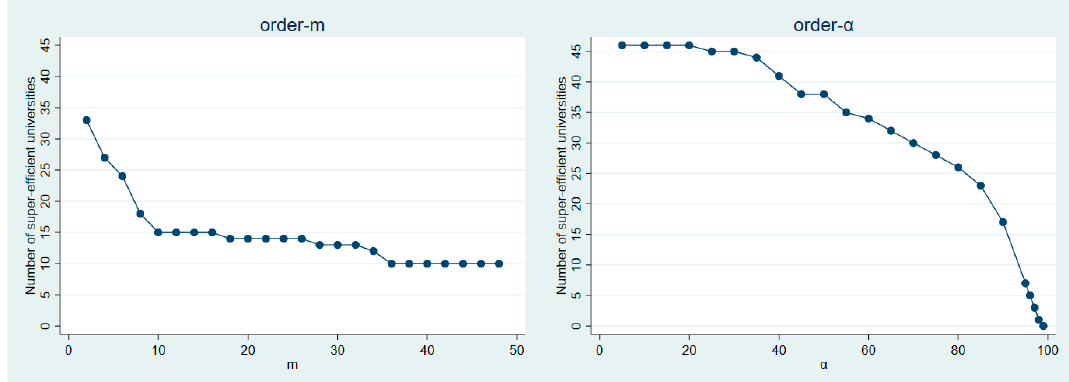
Figure 2. Number of super-efficient universities for different values of m and α .